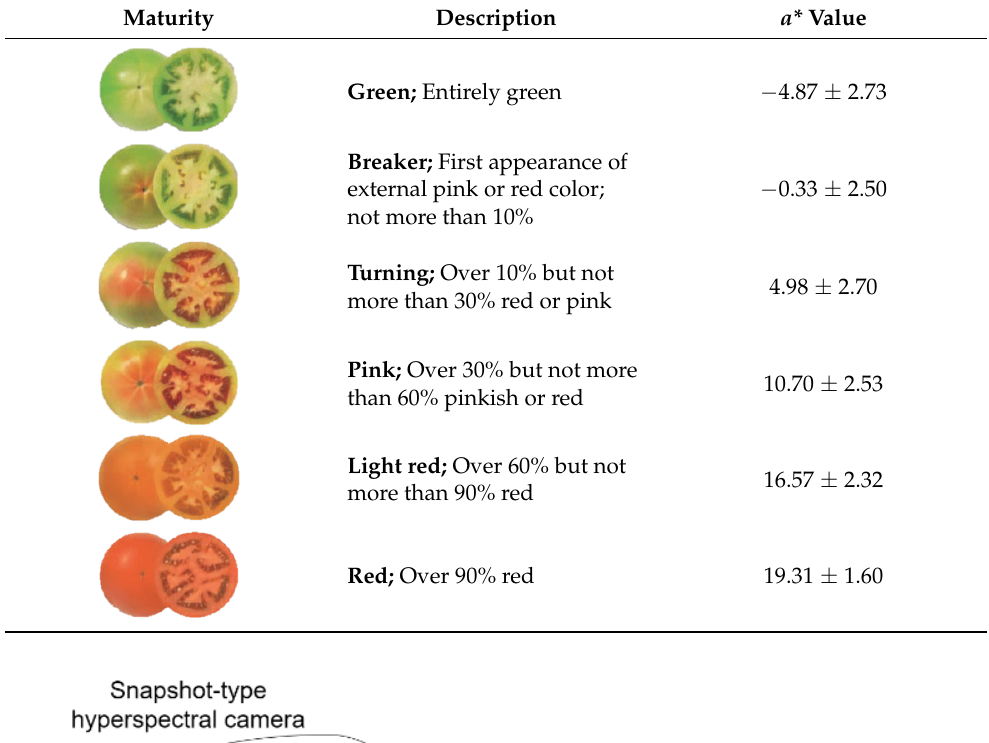
Table 1. Maturity stages of tomato fruits.